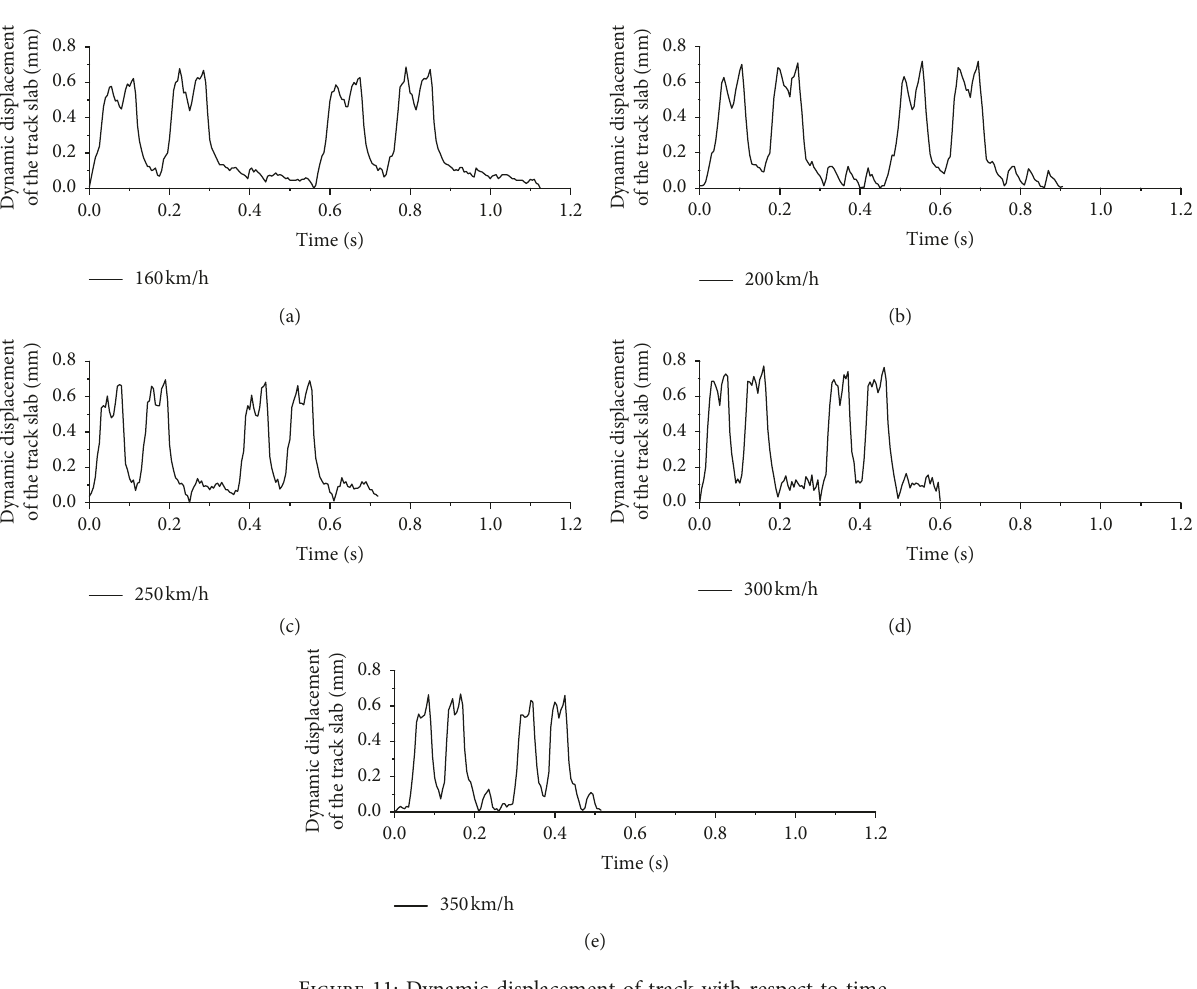
Figure 11: Dynamic displacement of track with respect to time.